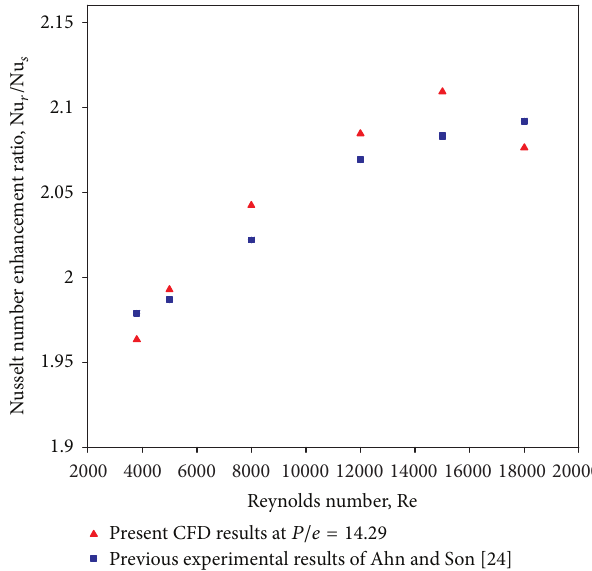
Figure 13: Comparison of friction factor predicted by present CFD investigation with the previous experimental results of Ahn and Son